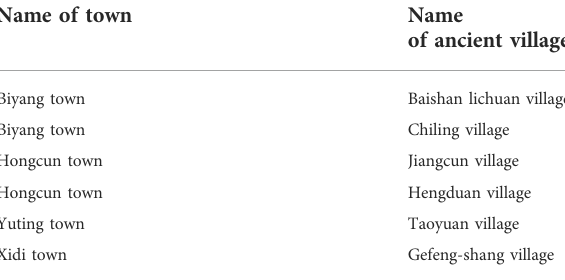
TABLE 1 Case study of the six ancient